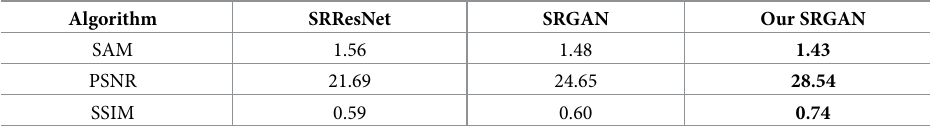
Table 3. Experimental results of different algorithms on UCAS-AOD dataset. Algorithm